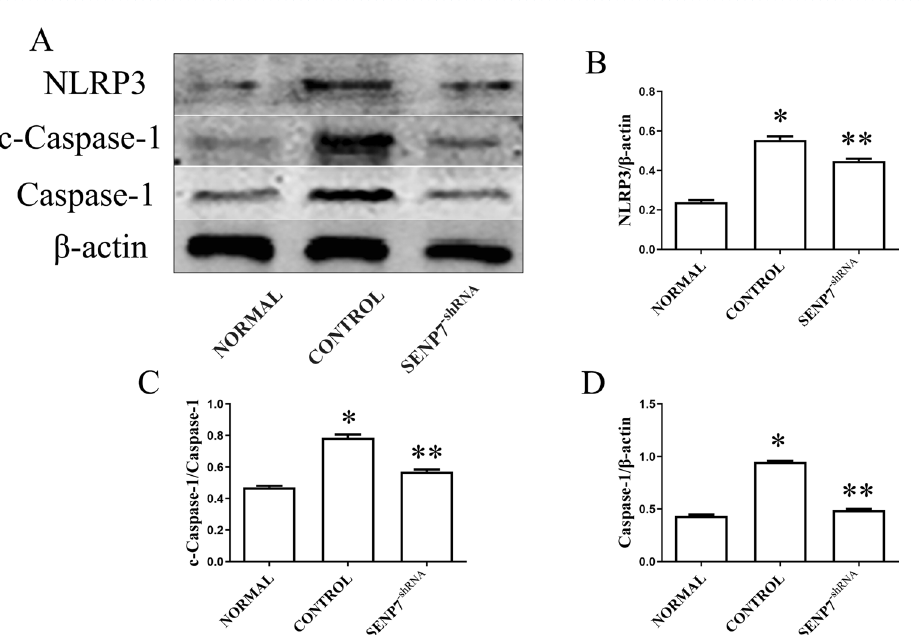
Figure 4. SENP7 knockdown inhibits NLRP3 activation in Raw 264.7 cells. ( A ) The expression levels of NLRP3, caspase-1 and cleaved-caspase-1 detected by western blot assay. ( B – D ) The relative protein expression levels from three independent experiments are represented as the density of NLRP3 and Caspase-1 bands normalized to that of β-actin bands or the density of cleaved-caspase-1 bands normalized to that of caspase-1 bands. NORMAL: Raw 264.7 cells without any treatment; CONTROL: Raw 264.7 cells treated with LPS + ATP; SENP7 -shRNA : SENP7 stable knockdown Raw 264.7 cells treated with LPS + ATP. Compared with the NORMAL group, * p < 0.05, compared with the CONTROL group, ** p <